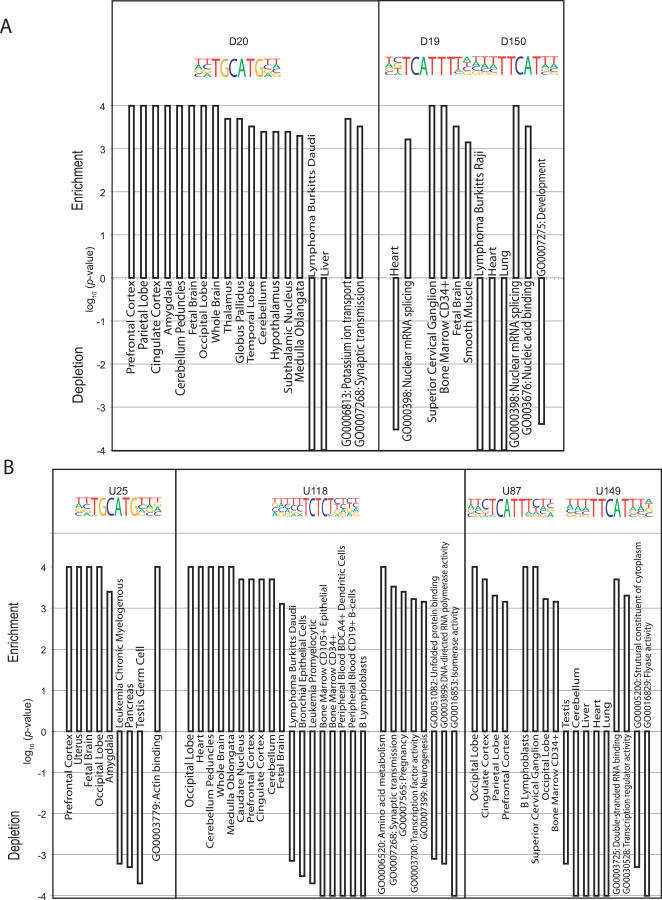
Several Examples of GO and Tissue Expression Biases for Genes Containing ISRE-Proximal ExonsA gene is defined as differentially expressed in a specific tissue or cell line if its expression in the tissue or cell line is two standard deviations above the median expression across all tissues/cell lines. We denote genes that contain ISRE-proximal exons as ISRE genes. For each ISRE, the tissues or cell lines in which the ISRE genes were significantly enriched (positive value) or depleted (negative value) are illustrated, followed by the enriched or depleted GO terms. The y-axis is the log10
p value for significance. For notational simplicity, a minus sign indicates significantly depleted values. Please refer to Protocol S1 for details on controlling for background conservation in the intronic sequences.(A) Downstream ISREs.(B) Upstream ISREs.